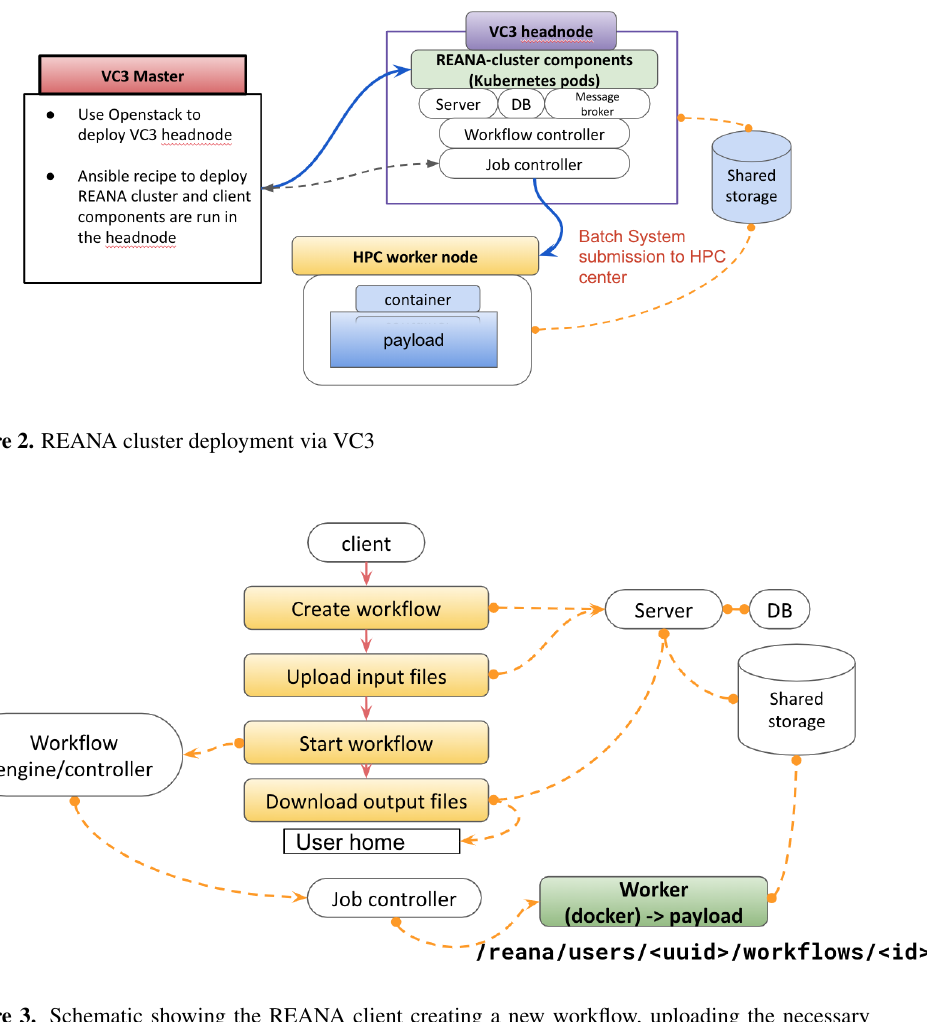
Figure 3. Schematic showing the REANA client creating a new workflow, uploading the